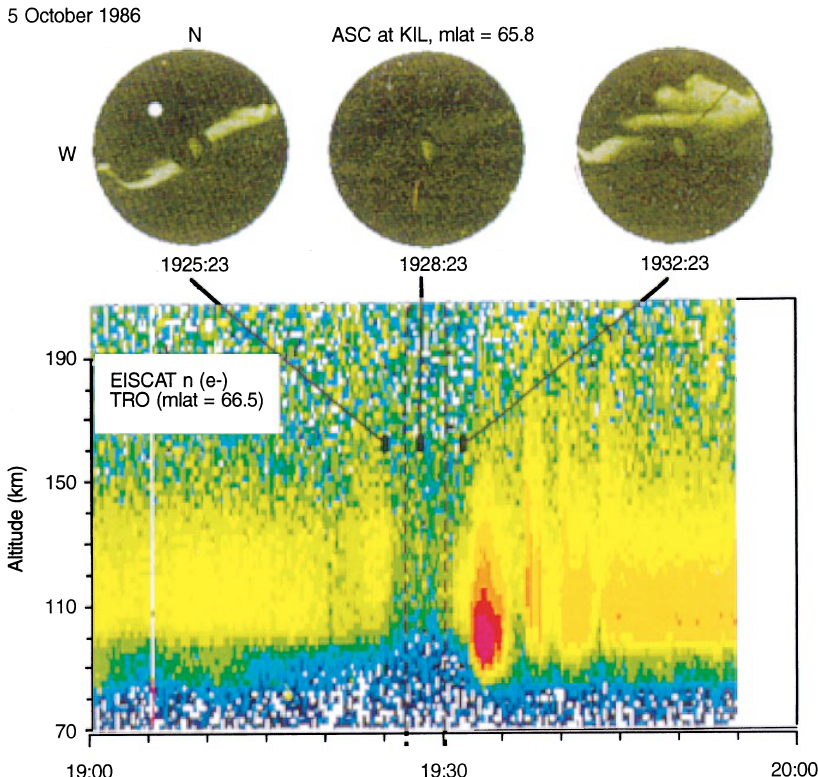
Fig. 1. Fading event on 5 October 1986: ( upper panel ) ASC frames recorded at KIL, and ( lower panel ) electron density recordings by the EISCAT radar at TRO ( red, yellow, and green correspond to electron densities 10 12 , 2 : 5 (cid:1) 10 11 , and 6 : 3 (cid:1) 10 10 m (cid:255) 3 , respective- ly). The approximate location of the field- aligned radar beam is marked with the white dot in the first